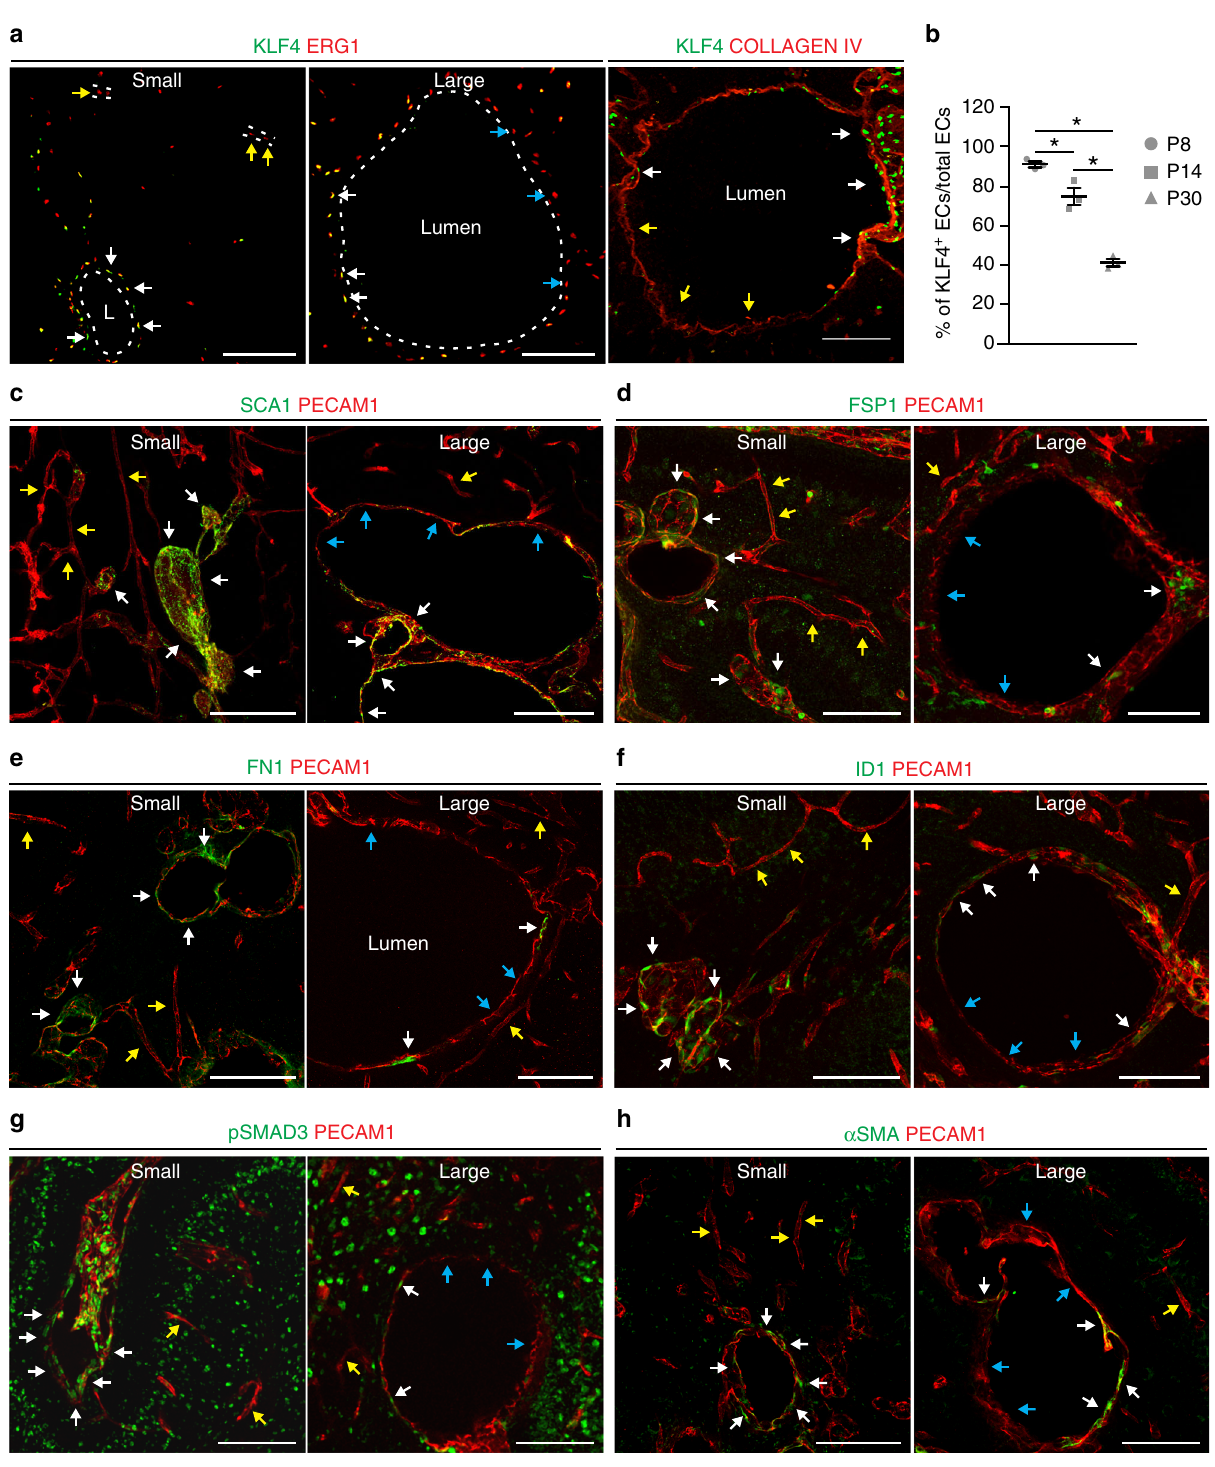
Fig. 4 Large cavernomas are mosaic. a Representative images of chronic Cdh5(PAC)- Cre-ER T2 / Ccm3 f/f mice co-stained for KLF4 (green) and either ERG1 or COLLAGEN IV (red). b Quanti fi cation of the percentage of KLF4-positive endothelial cells lining the cavernomas of chronic P8, P14 and P30 mice. Data are means ± SE; p < 0.001 among groups (one-way analysis of variance); * p < 0.01 (Tukey ’ s post hoc test); n = 3 mice in each group. Source data are provided as a Source Data fi le. c – h Representative images of brain sections co-stained for PECAM1 (red) and mesenchymal markers (green), showing small lesions from P8 mice and large cavernomas from P14 mice. White arrows, endothelial cells positive for mesenchymal markers within the lesions; yellow arrows, endothelial cells negative for mesenchymal markers in normal vessels; blue arrows, endothelial cells negative for mesenchymal markers within the lesions. Scale bars, 100 μ